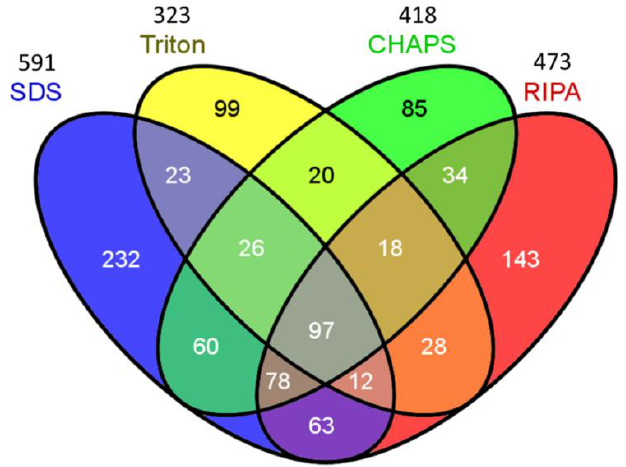
Figure 2. Analysis of the Venn diagram on the identified proteins. (cutoff: protein probability 95%, minimum peptides 2, minimum peptide probability